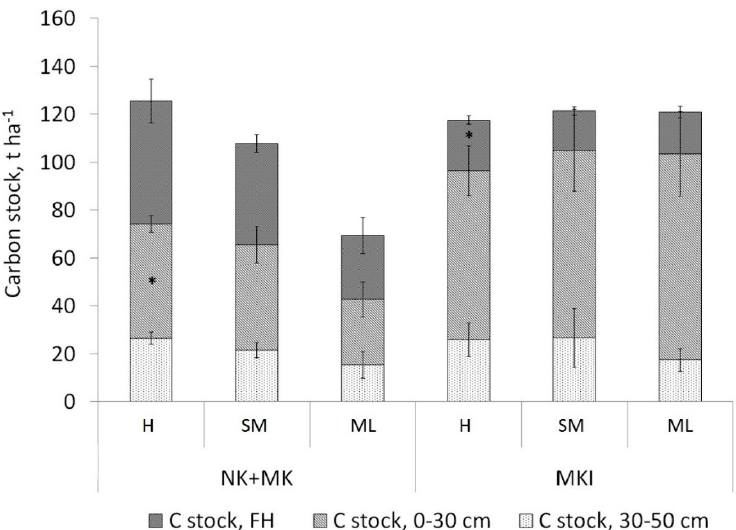
Figure 8. Soil carbon stocks in Karelian forests (NK + MK) on Carbic Albic Podzols with a high proportion of herbaceous plants (H, n = 18), with dwarf shrubs + green mosses (SM, n = 46), and with green mosses+ lichens/green mosses (ML, n = 5), and in the forests of the Karelian Isthmus on Albic Retisols with a high proportion of herbaceous plants (H, n = 22), with dwarf shrubs + green mosses (SM, n = 9), and with green mosses + lichens/green mosses (ML, n = 9). The significance of the differences between the mean in category and overall mean was estimated taking into account the areas (NK + MK and MKI).